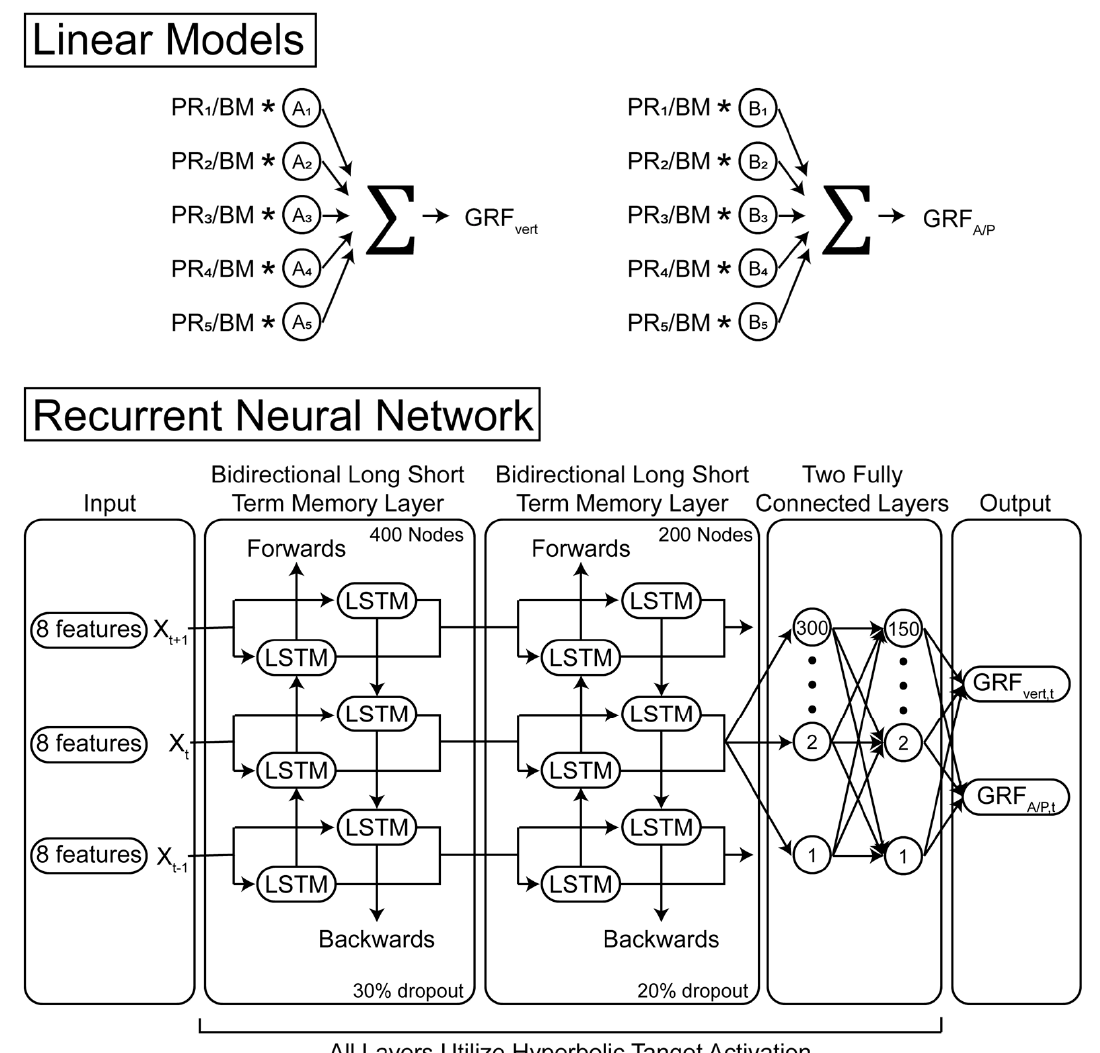
Figure 3. Linear and recurrent neural network model architecture for computing vertical (vert) and anterior–posterior (A/P) ground reaction forces (GRF). The linear models predicted vertical and A/P GRFs from five different pressure regions (PR 1–5 ) divided by subject − specific body mass (BM). The coefficients (A 1–5 , B 1–5 ) were computed using a least − square regression. The recurrent neural network predicted GRFs based on eight different inputs: PR 1–5 , body mass, speed and slope. The bidirectional long short − term memory (LSTM) layers utilized information from the current sample (x t ) and from the future (x t+1 ) and previous samples (x t-1 ). For example, the GRF at 1% of the step is informed from the input at 0%, 1%, and 2% of the step. Both models were cross − validated using a leave − one subject out approach.